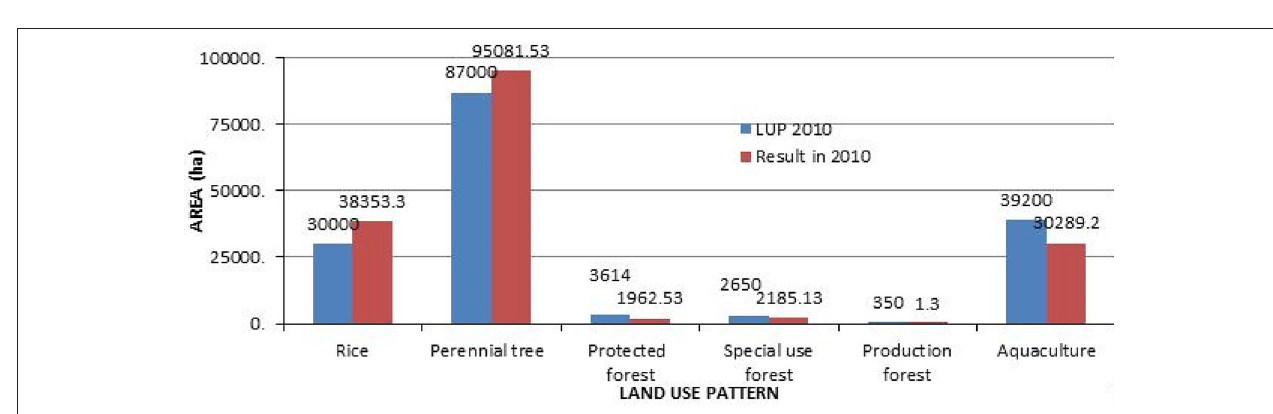
FIGURE 2 | Land-use planning assessment of Ben Tre province in 2010. Source: Department of Environmental and Natural resources of Ben Tre province, Vietnam (PCBT, 2011).